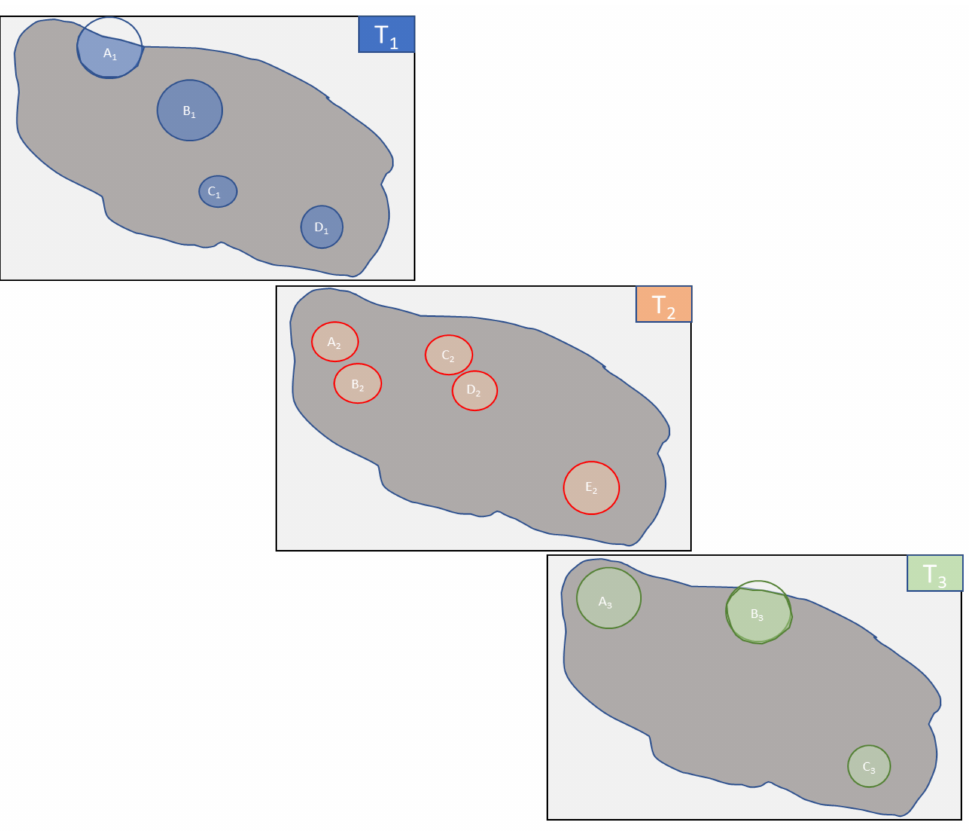
Figure 1. Example of hot spots detected and plotted in an